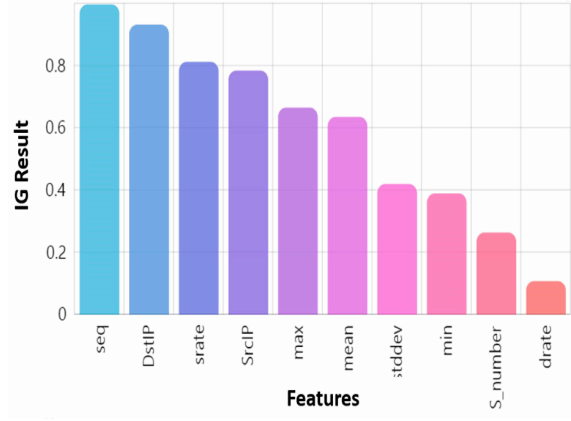
Figure 5. Features Ranking Based on Information Gain. Table 5. BoT-IoT best 10 features